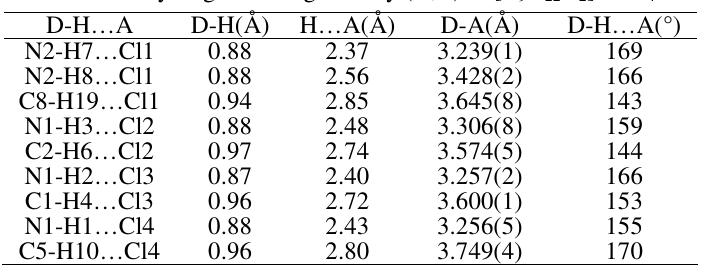
Table 3. Hydrogen-bond geometry (Å, °) in [C